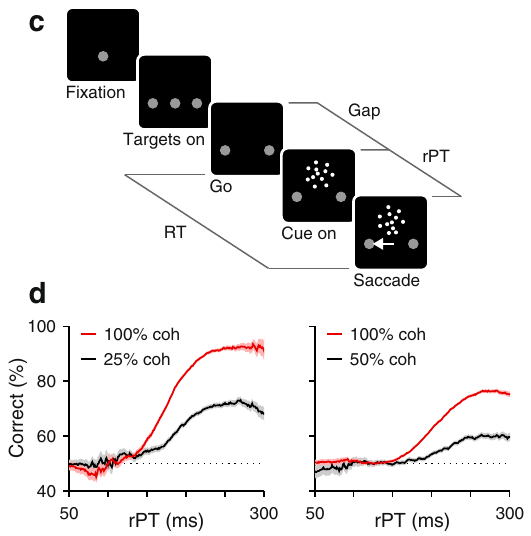
Fig. 1 | Urgent and non-urgent motion discrimination tasks. Subjects had to reportthedirectionofmotion(leftorright)ofacloudof fl ickeringdotsbylooking at one of two peripheral targets. a RDM task (non-urgent). The motion stimulus is presented and evaluated fi rst (between Cue on and Cue off, 600 – 1000 ms), well before the go signal ( fi xation point offset; Go). The time interval between the go andsaccadeonset(RT)isindicated. b PerformanceintheRDMtaskasafunctionof motion coherence. Results are from behavioral (black circles) and recording ses- sions (cyan circles) from monkeys C (left; 7363 behavior trials; 8685 recording trials) and T (right; 4547 behavior trials; 3952 recording trials). Points indicate percentage of correct choices across trials and error bars indicate 95% con fi dence intervals. c CRDMtask(urgent).Thegosignal(Go)ispresented fi rstandthemotion